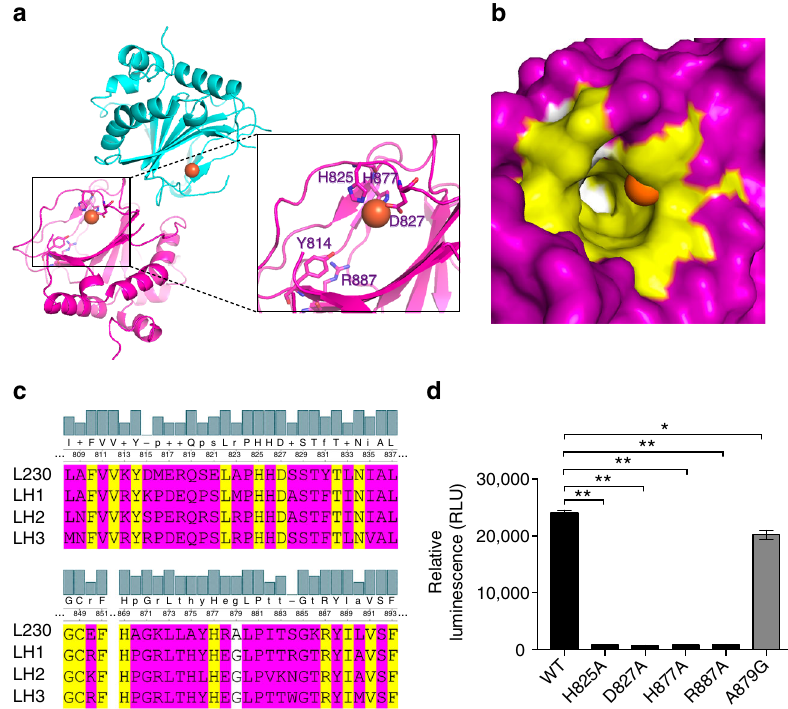
Fig. 1 The active site of the L230 LH domain. a Ribbon diagram of the L230 LH domain. H825, D827, and H877 coordinate with Fe 2+ (orange); Y814 and R887 are positioned to bind to 2-OG (inset). b Surface view of L230 active site. Locations of Fe 2+ (orange) and the residues facing the 2-OG-binding pocket that are conserved (yellow) or not conserved (white) in human LH2 are indicated. Residues outside of 2-OG-binding pocket are in purple. c Sequence alignment of L230 with human LHs. Conserved (yellow) and non-conserved (A879, white) residues within the 2-OG-binding pocket and residues outside the 2-OG-binding pocket (purple) are indicated. d L230 enzymatic assay using bovine skin collagen as substrate. Enzymatic activity is ablated by loss of residues involved in Fe 2+ - and 2-OG-binding but not a non-conserved residue (A879). Results are mean values ( ± S.D.) from biological triplicate samples. p values, two-tailed Student ’ s t